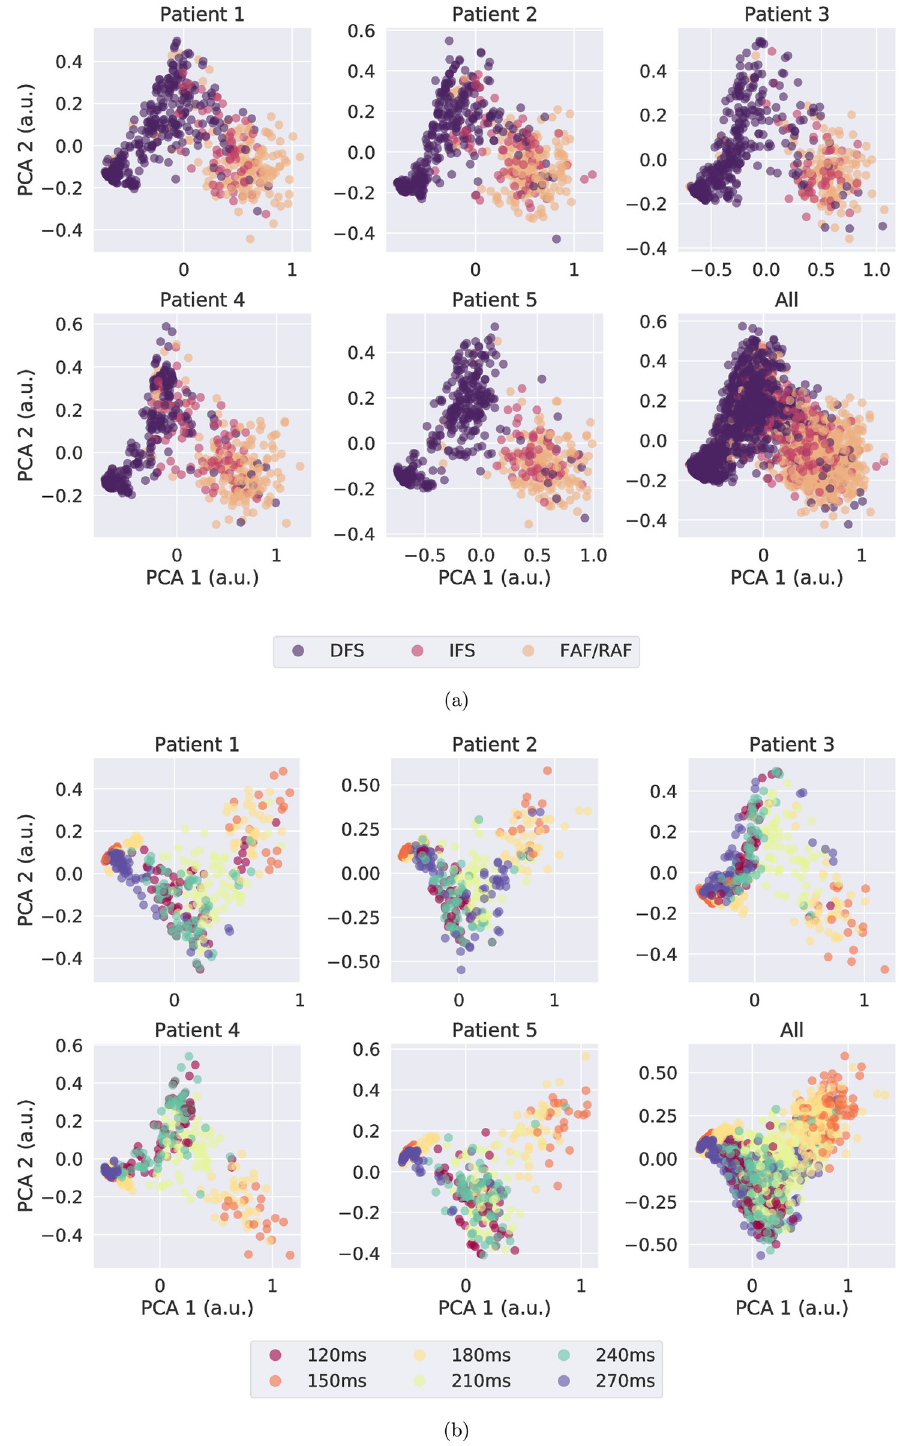
Fig 7. Two-dimensional PCA representation of MaxAC values obtained from SO-BSS with K = 10 over simulated BSPMs), on each patient and all pooled, for different colour-coded groupings: (a) all categories over all episodes, and (b) focal CLs over all FS episodes. Clustering based on categories and focal CLs can be seen for each patient. a.u.: arbitrary unit.